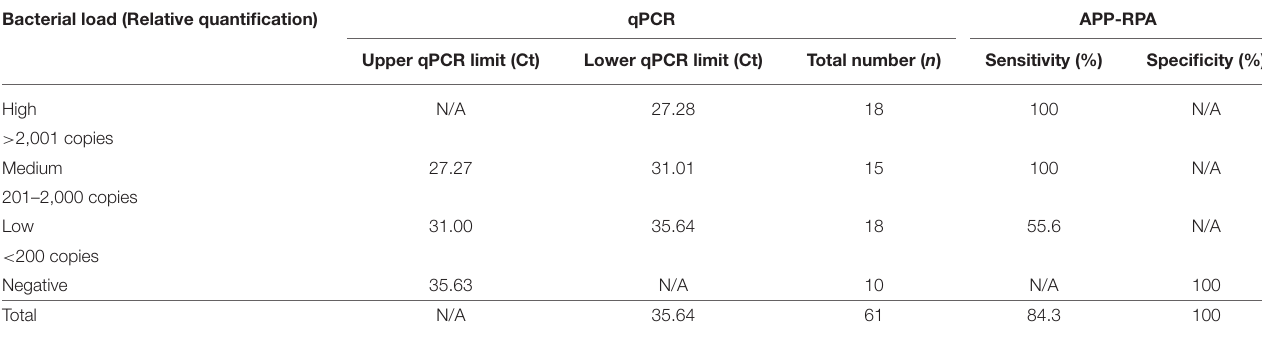
TABLE 2 | Performance of APP-RPA in 61 clinical samples.